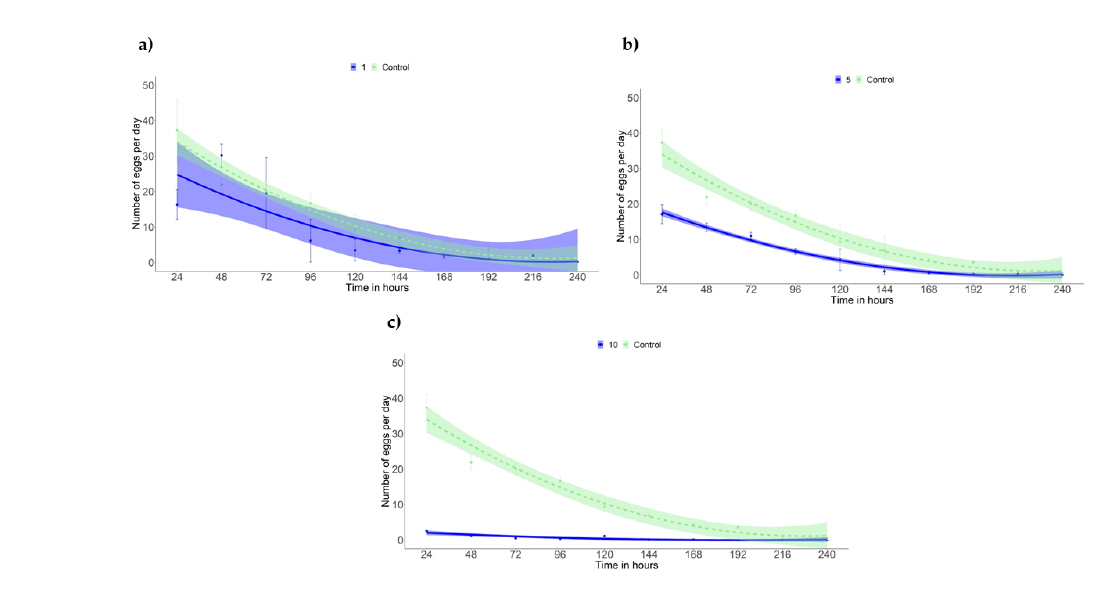
Figure 4. Number of eggs laid per day. Comparison between control (distilled water) and M. albicans extracts at concentrations of 1% ( a ), 5% ( b ), and 10% ( c ). extracts at concentrations of 1% ( a ), 5% ( b ), and 10% ( c